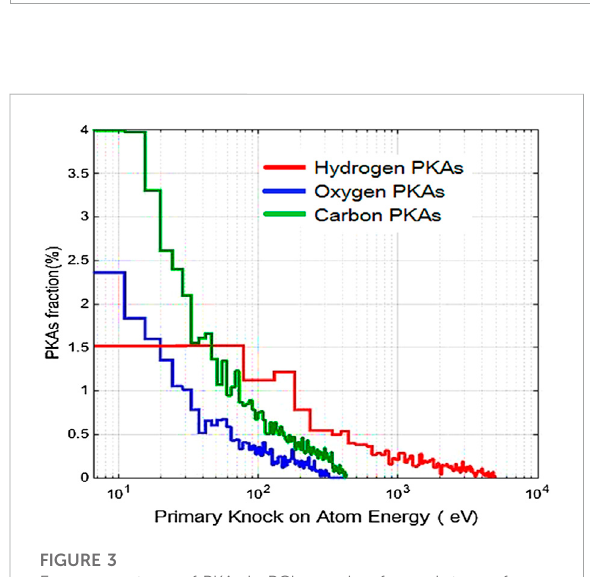
FIGURE 3 Energy spectrum of PKAs in PCL samples, for each type of primary knocked-out atoms (hydrogen, carbon, and oxygen) sterilized with cobalt-60 gamma-ray source and 5 eV threshold energy by Monte Carlo method.